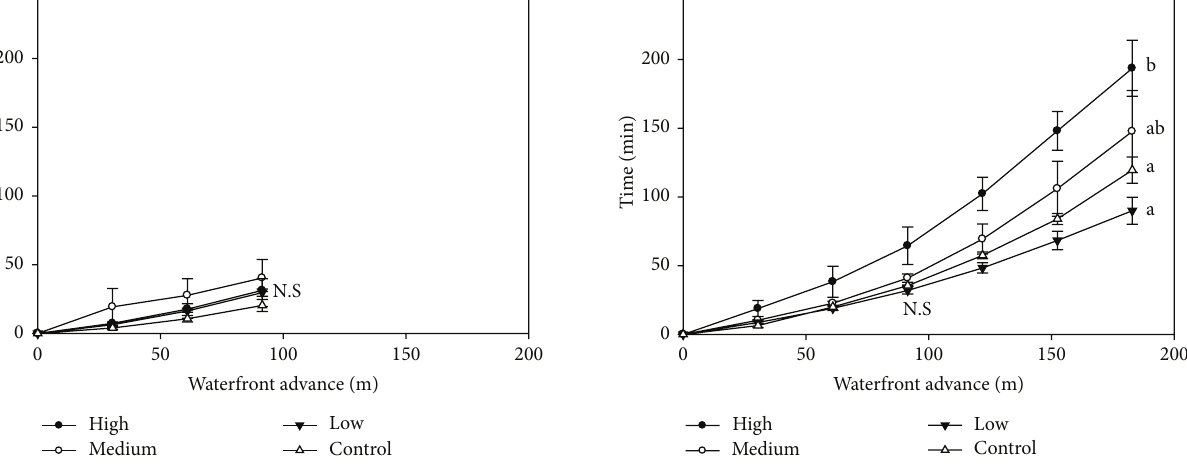
Figure 2: The waterfront advance time at 30, 61, and 91 m from the inflow of the 91m long field. The error bars represent the standard error. The High, Medium, Low, and Control residue treatments represent varying amounts of residue biomass in the furrow. NS = nonsignificant differences.